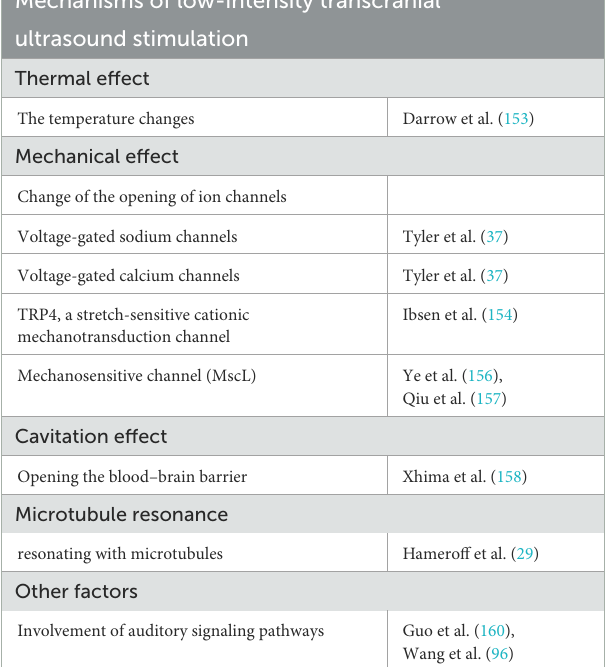
TABLE 4 Mechanistic study of transcranial ultrasound stimulation in the treatment of central nervous system diseases. Mechanisms of low-intensity